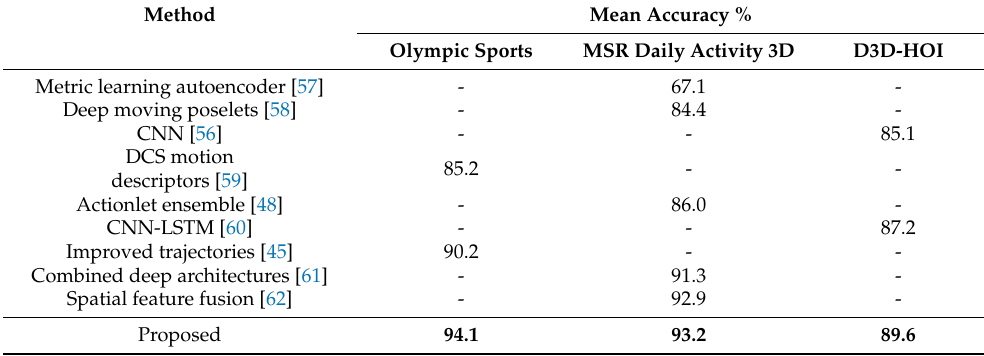
Table 9. A comparison of proposed HOIR system with other state-of-the-art